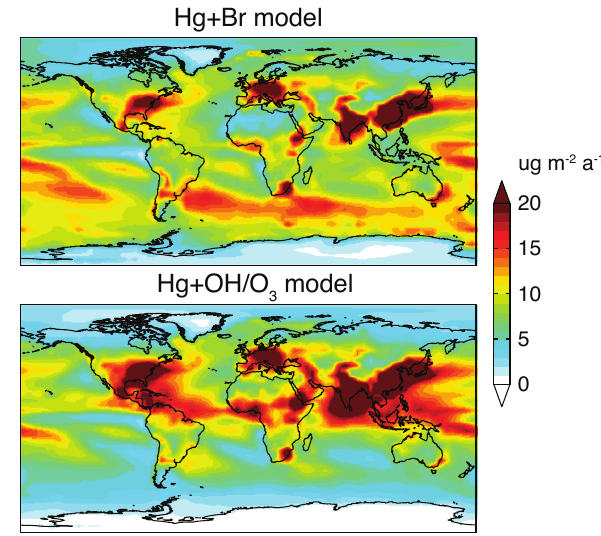
Fig. 13. Annual deposition fluxes of Hg II plus Hg P in the Hg+Br and Hg+OH/O 3 models. Both models have 5100Mga − 1 total de-